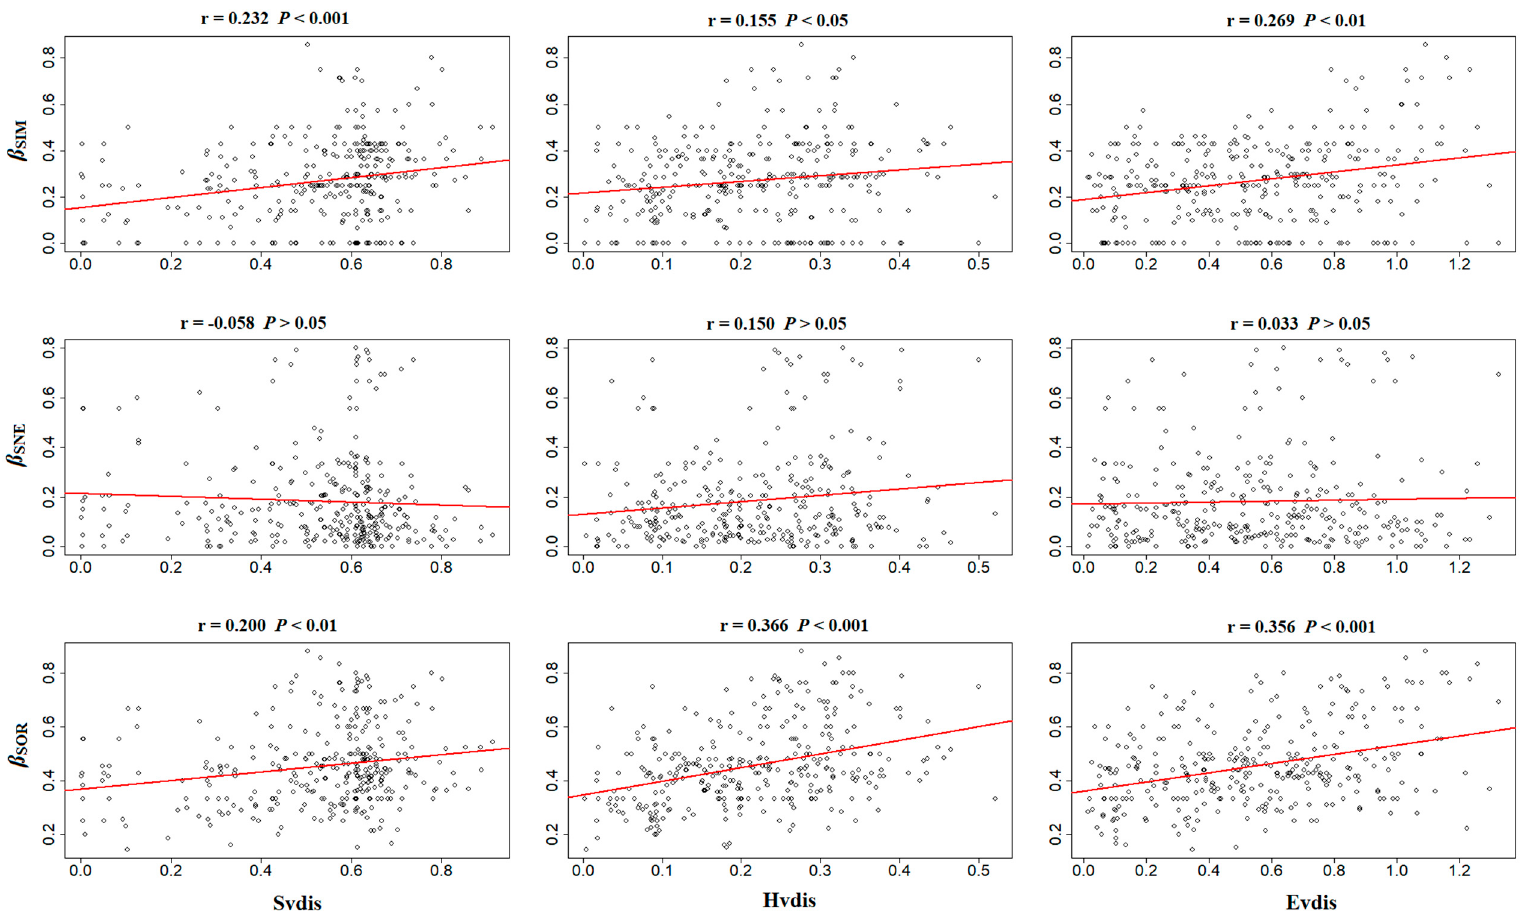
Figure 4. Relationship between Sørensen indices ( ß SIM, ß NES, and ß SOR ) and dissimilarity matrices based on Euclidean distances for spatial (Svdis), hydrological (Hvdis), and environmental (Evdis) variables in upstream Lijiang River. For other abbreviations see Table 1.